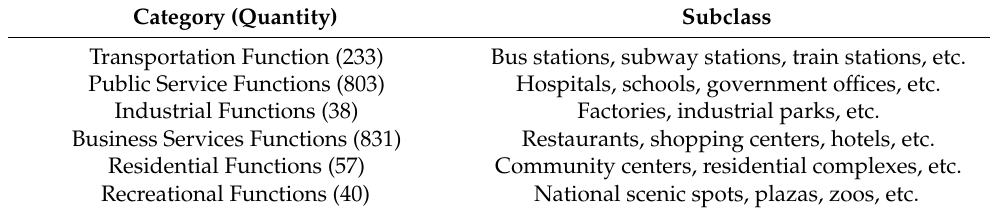
Table 2. POI data